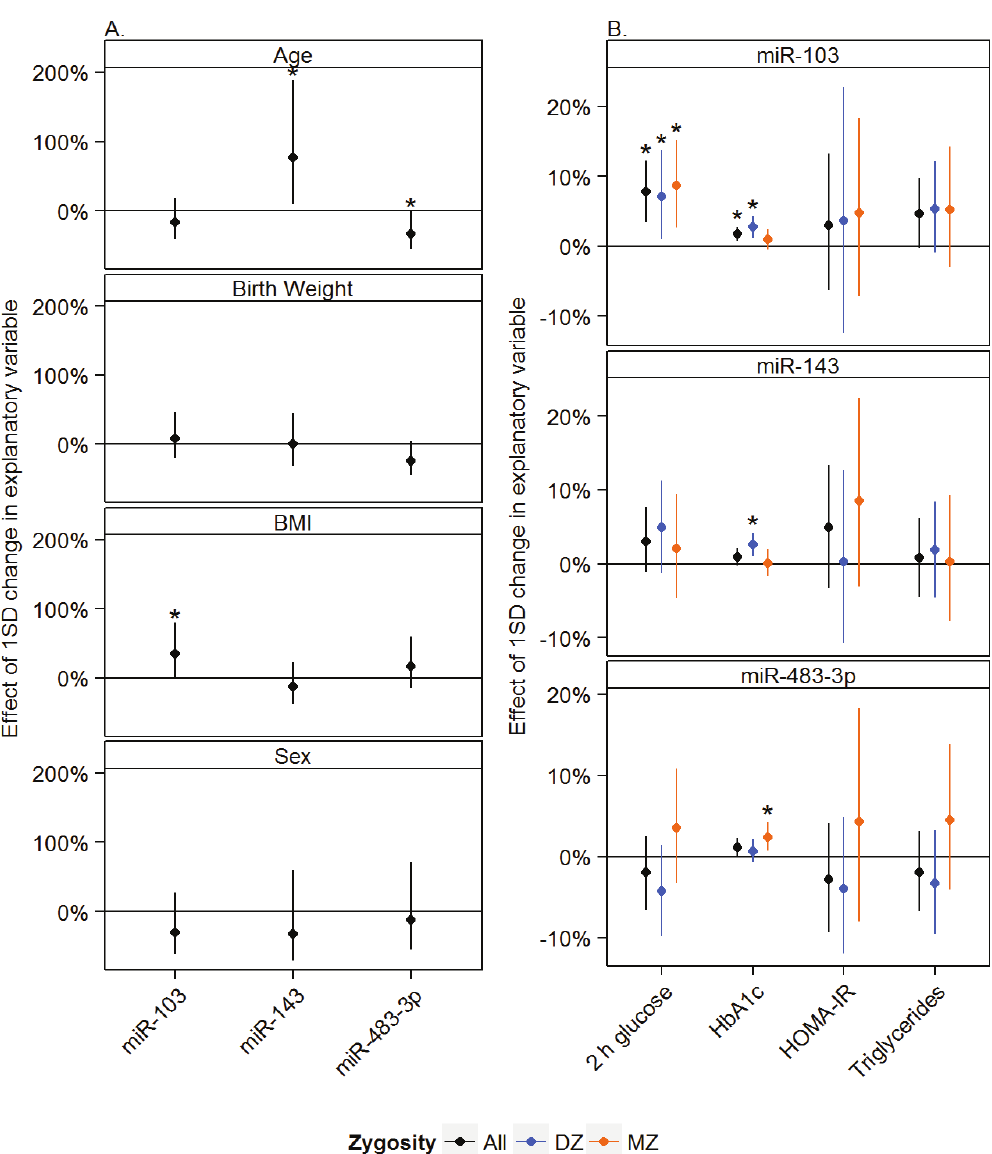
Figure 1. Multivariate analyses were performed to study the association between ( A ) age, birth weight, BMI and sex and miR-103, miR-143 and miR-483-3p expression in adipose tissue from elderly twins and the association between ( B ) miR-103, miR-143 and miR-483-3p and 2 h glucose values after an oral glucose tolerance test, hemoglobin A1c (HbA1c), homeostatic model assessment of insulin resistance (HOMA-IR) and triglycerides shown for all subjects (black), dizygotic (DZ) twins (blue) and monozygotic (MZ) twins (orange). Effect measures were transformed to percent wise changes per standard deviation (SD). Mean effects are shown by ●. Error bars represent the 95% confidence interval. All analyses were adjusted for age, sex and BMI. In addition the analyses of age, BMI and sex were adjusted for birth weight. Analyses involving all subjects (black) were additionally adjusted for twin and zygosity status. A p - value of ≤0.05 was considered significant, and is indicated by * . Body mass index (BMI), plasma glucose measured at 2 h in an oral glucose tolerance test (2 h glucose), homeostatic model assessment of insulin resistance (HOMA-IR), hemoglobin A1c